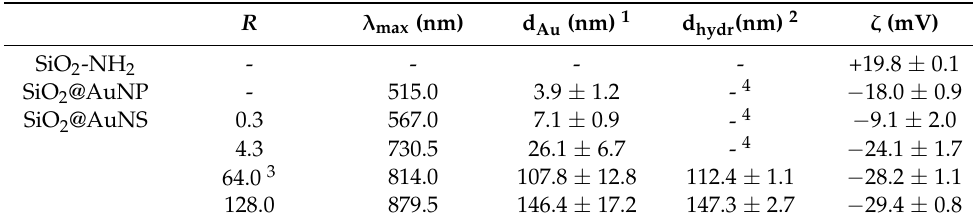
Table 1. Overview of [HAuCl 4 ]/[seed] ratio ( R ), extinction maxima (λ max ), the size of the gold nanostructure (d Au ) as well as the hydrodynamic diameter (d hydr ) and the zeta- potential (ζ) of the